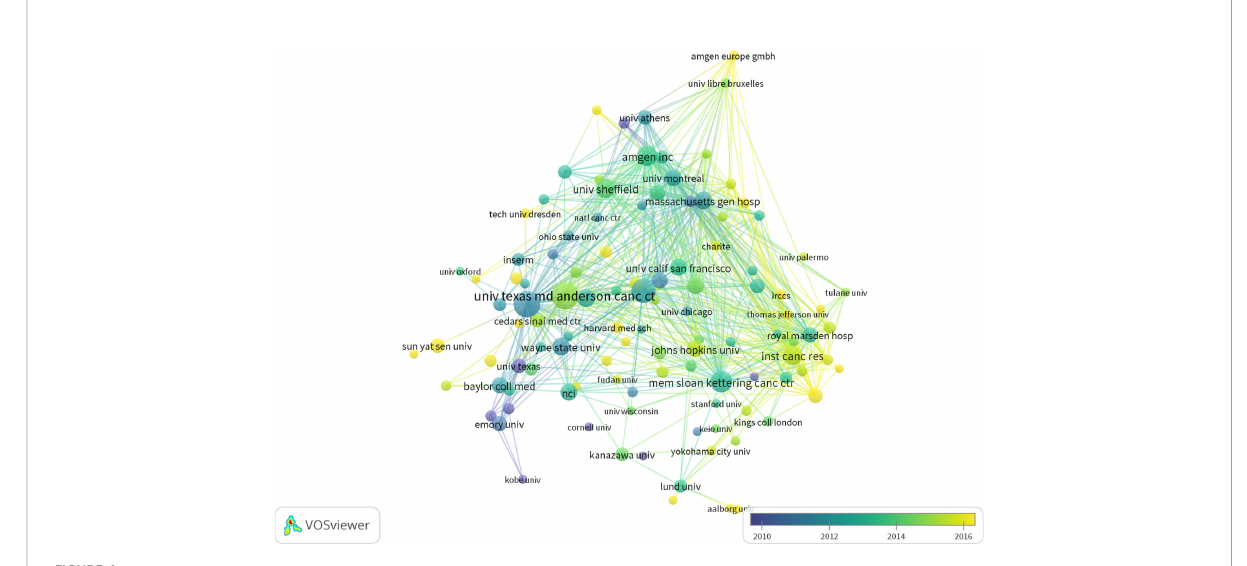
FIGURE 4 Overlay visualization map of the institutions with more than 20 articles.